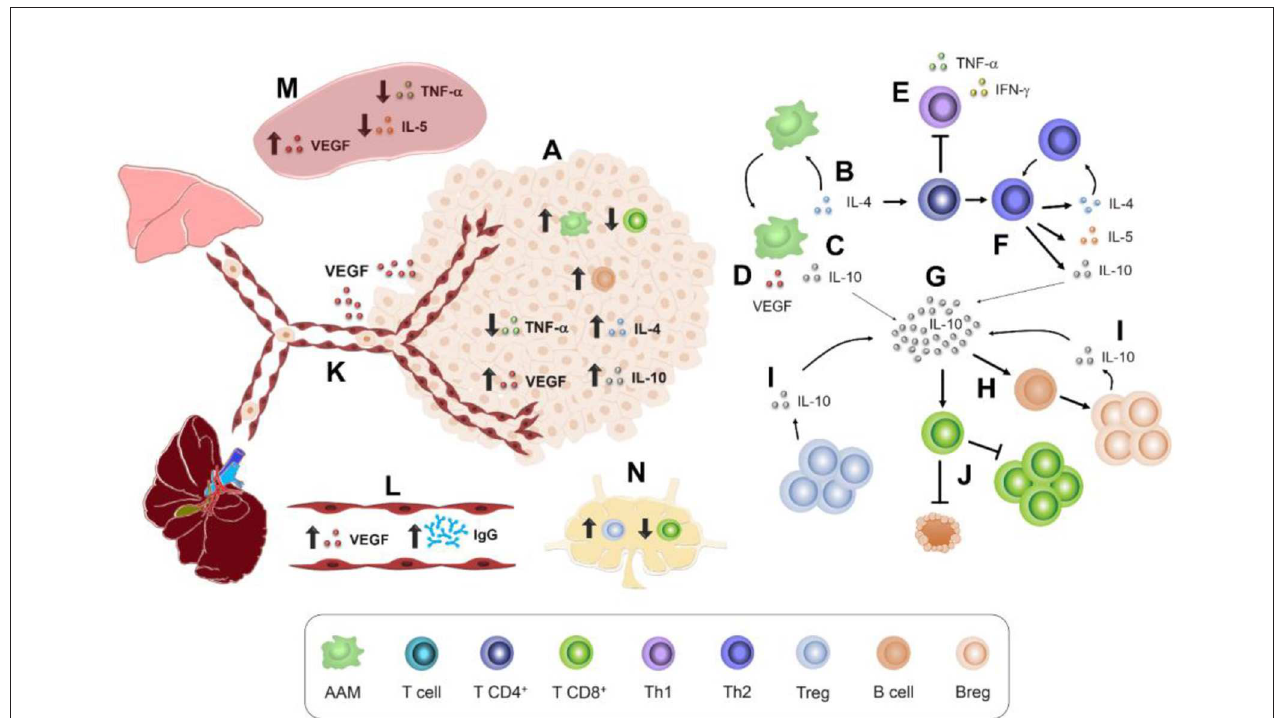
FIGURE 7 | Immune interactions in 4T1 tumor-bearing mice chronically infected with T. canis . (A) Tumor immune microenvironment. AAM secretion of: (B) IL-4. (C) IL-10. (D) VEGF. (E) Th1 polarization inhibition. (F) Th2 polarization promotion by IL-4. (G) IL-10 production and stimulus in different immune cells. (H) B lymphocyte conversion to Breg lymphocytes. (I) IL-10-secretory Breg cells. (J) Inhibitory effect of IL-10 on T CD8 + proliferation and cytotoxic activity. (K) VEGF promotes angiogenesis and pulmonary and liver metastasis. (L) Higher levels of anti- T. canis IgG and VEGF in serum. (M) Splenic immune microenvironment. (N) PLN immune cell milieu. ( Figure 7L ) and spleen ( Figure 7M ). Additionally, CD8 + T cytotoxic cells may eliminate tumor cells (38), and a reduced proportion within the tumor in T. canis -infected mice could allow a larger tumor size ( Figure 7A ). Together with a lower CD8 + cell percentage in tumor, in PLN, the decrease in this population in infected animals could be associated with the increased proportion of Treg (36) ( Figure 7N ). On a systemic level, higher serum T. canis -IgG levels were sustained in tumor- bearing mice ( Figure 7L ). With regard to splenic changes associated with T. canis infection, TNF- α and IL-5 decrease were detected ( Figure 7M